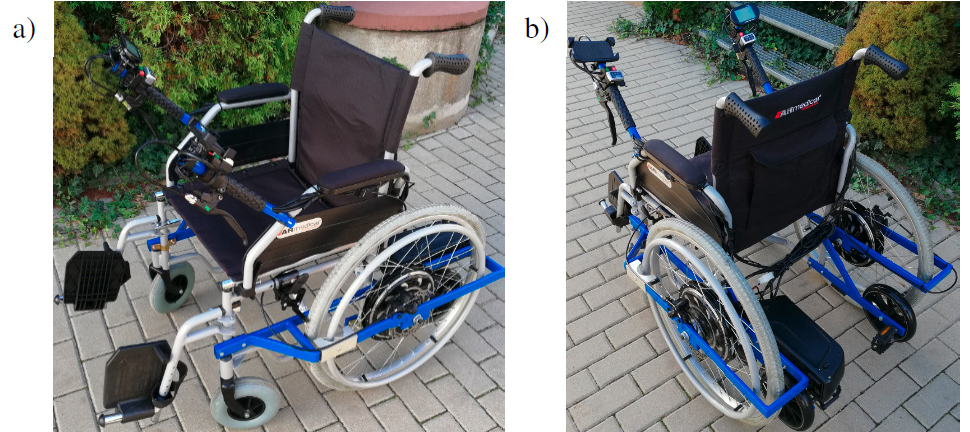
Figure 3. Prototype of a wheelchair equipped with a hybrid electric-manual propulsion module; ( a ) front view, ( b ) rear view.